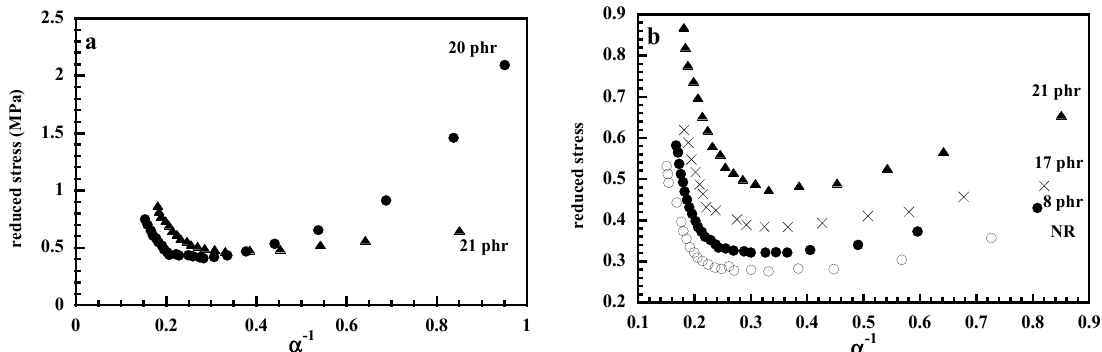
Figure 2. Mooney-Rivlin plots of NR composites: ( a ) submitted to the in situ silica filling process before ( • ) and after ( (cid:78) ) vulcanization; ( b ) filled in the vulcanized state and in comparison with the unfilled NR. Reproduced with permission from [27]. Copyright Elsevier,